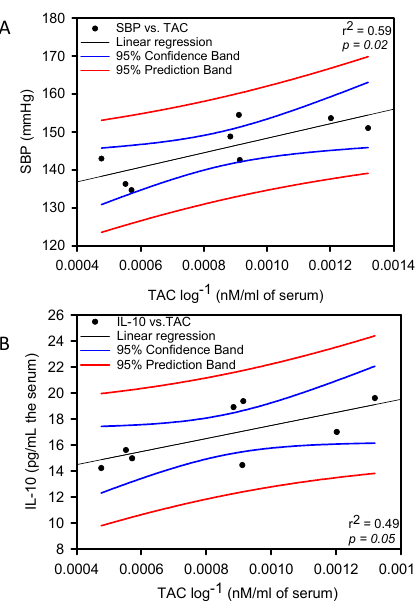
Figure 2. Linear regression between SBP vs. TAC panel ( A ) and IL-10 vs. TAC panel ( B ) Constant Variance Test Spearman Rank Correlation.